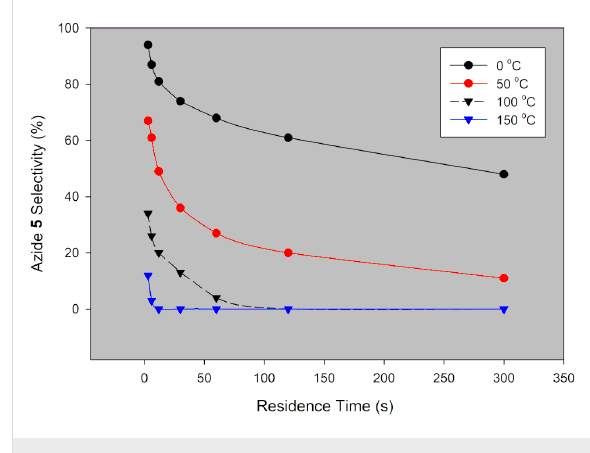
Figure 12: Desired azide 5 selectivity in a continuous-flow system using TMSA.